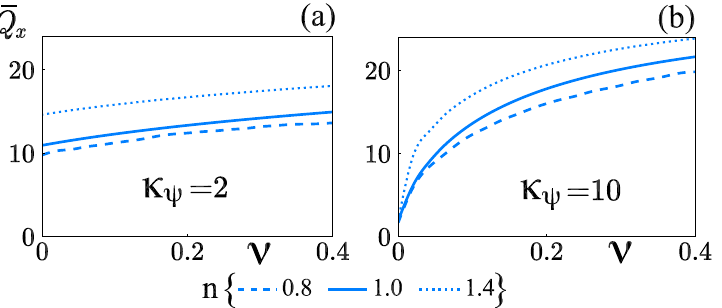
Figure 11. Rate of mass transport ¯ Q x as a function of Wo at different flow behavior indices n and the steric factor ν . ( a ) κ ψ = 2 and ( b ) κ ψ = 10.